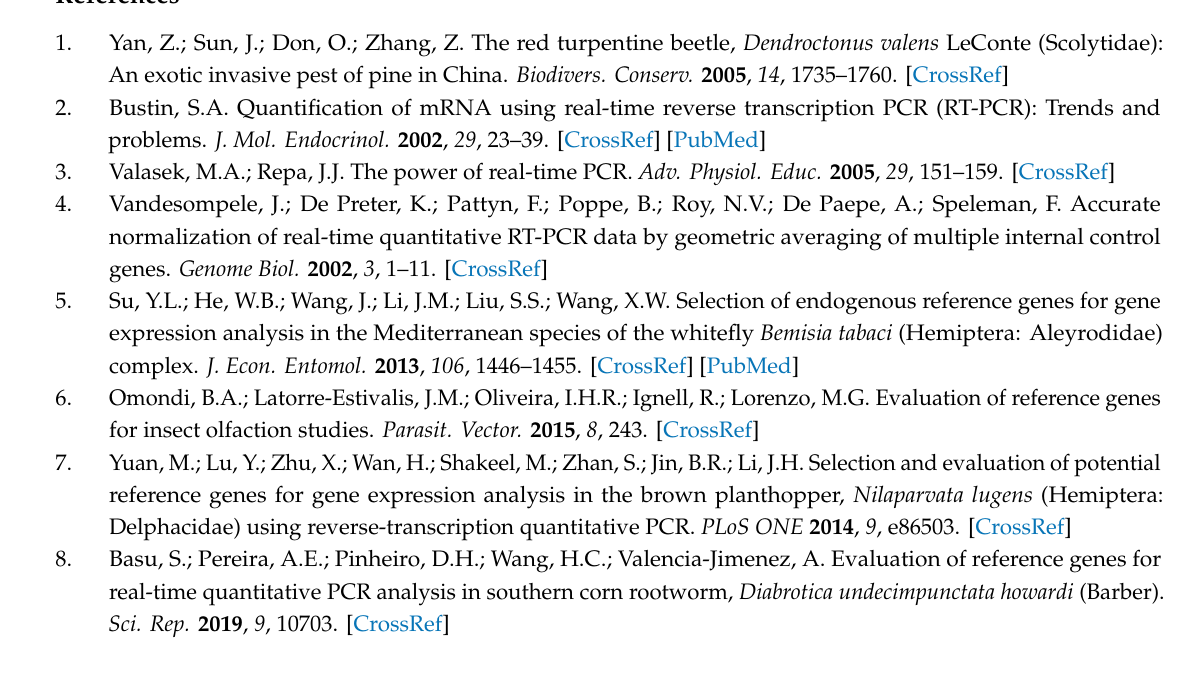
Figure S1: The design strategy of Primer3Plus, Figure S2: Specificity of real-time qRT-PCR amplification in Dendroctonus valens . Melting curves of six genes [ ACT (A), SDHA (B), 18S rRNA (C), RPS18 (D), CYP4G55 (E) and TUB (F)] reveal single